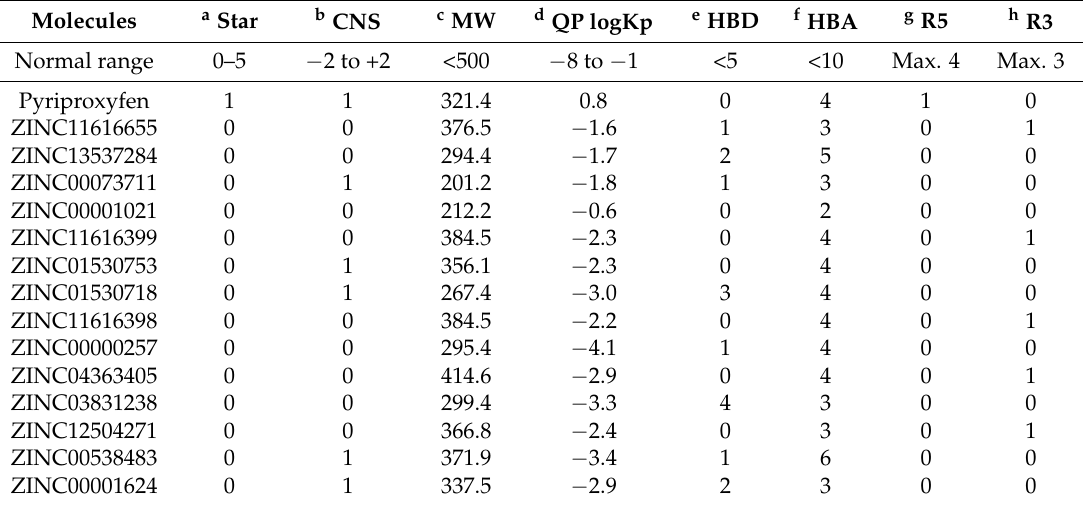
Table 1. Pharmacokinetic properties of selected